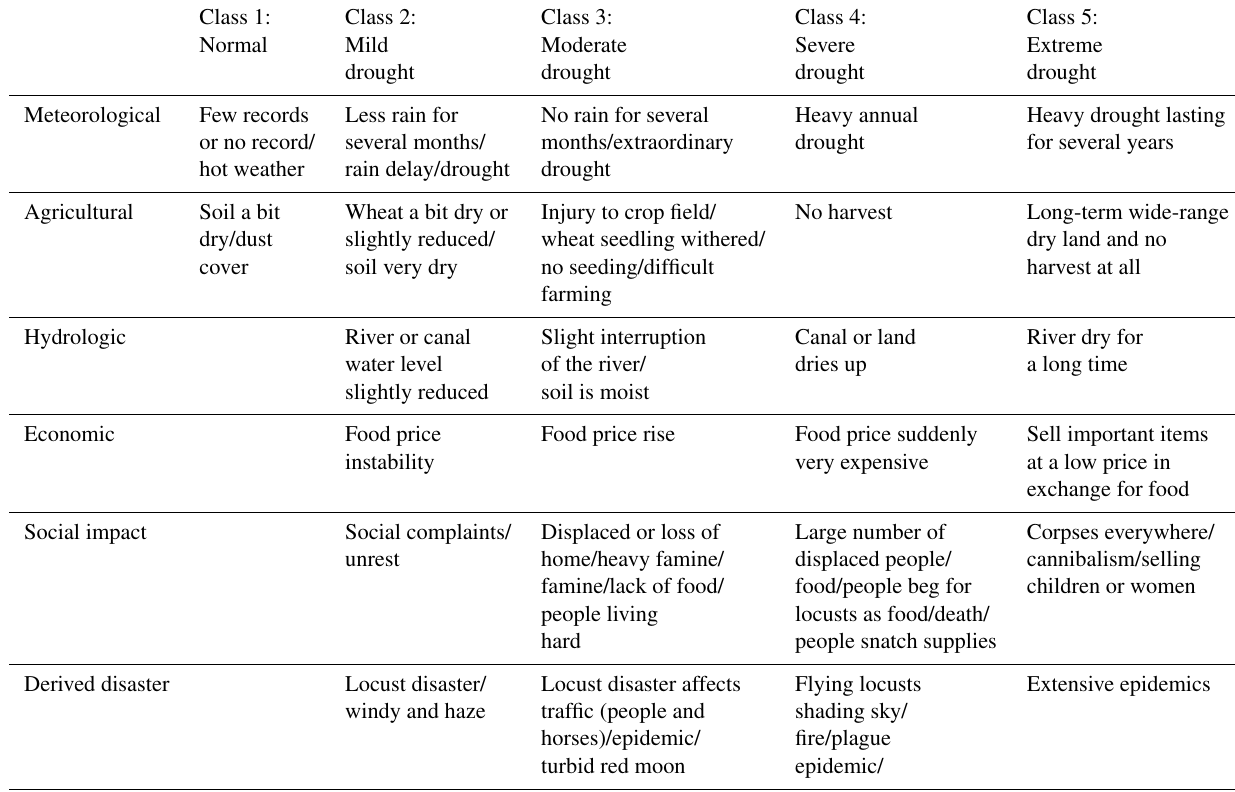
Table 4. Drought class and phenomenon comparison table. Class